Question: What type of chart is this?
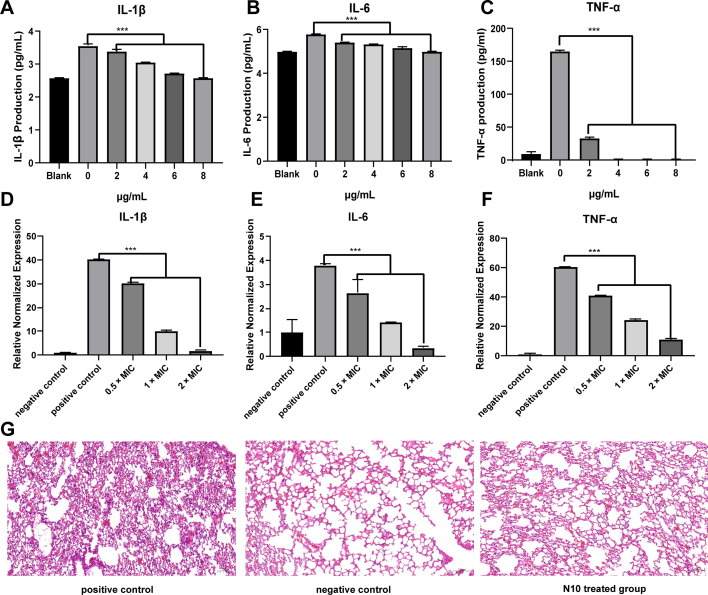
Answer: bar